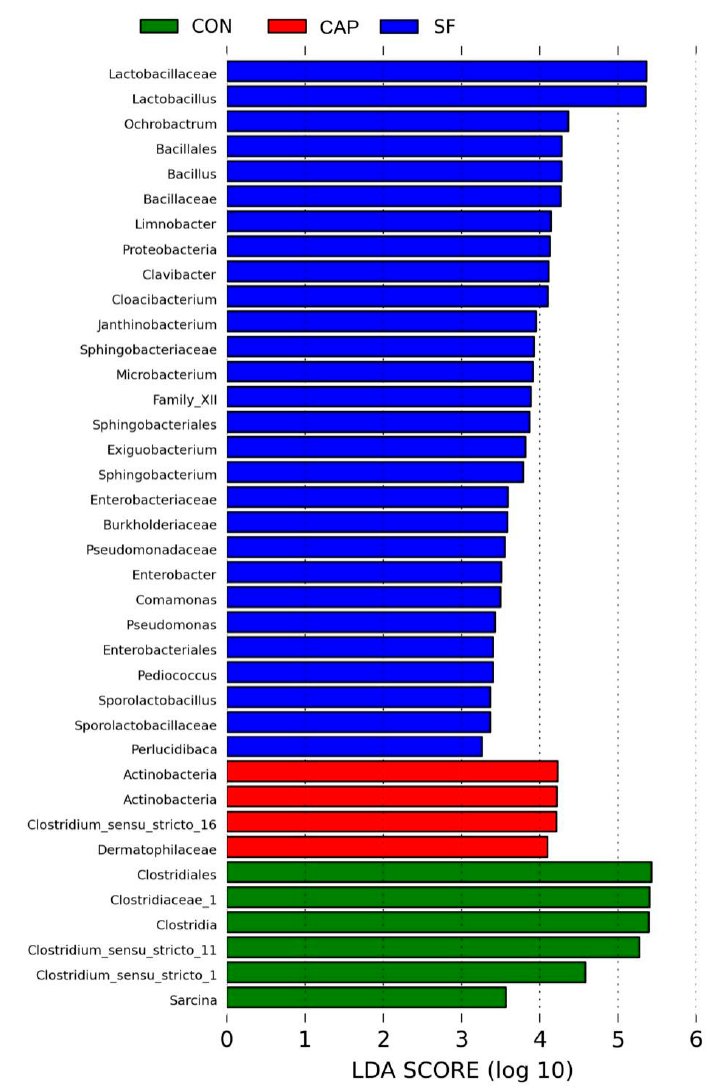
Figure 3. LEfse (Linear discriminant analysis Effect Size.) online tool was used to compare the microbial changes in wet brewers grains ensiled with sodium formate and calcium propionate after 20 days (CON, control group; SF, sodium formate; CAP, calcium propionate).